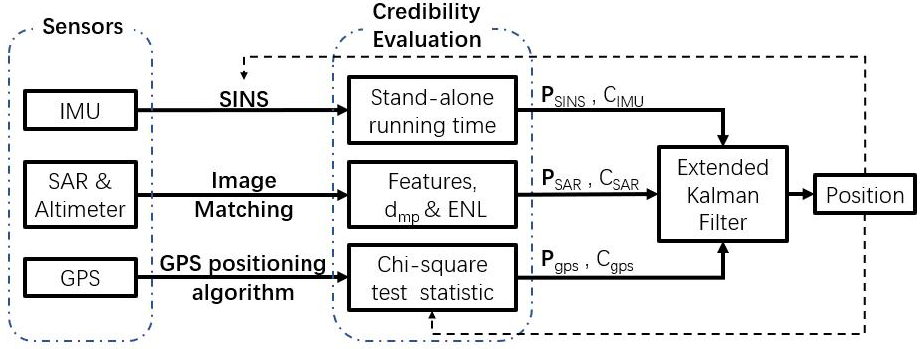
Figure 1. SINS/SAR/GPS credibility fusion positioning